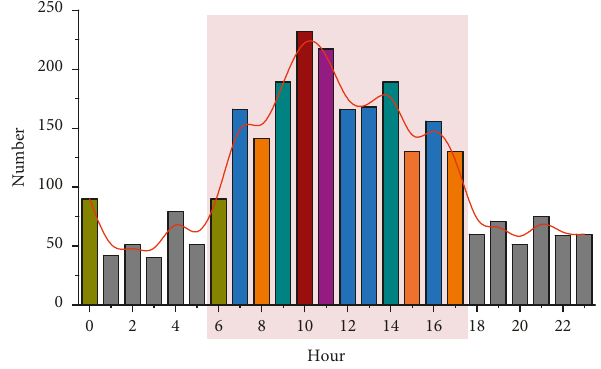
Figure 12: Hourly distributions of TTAs.